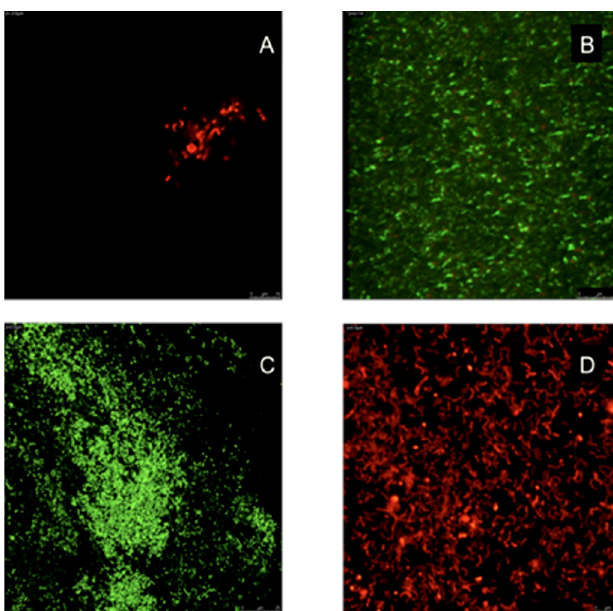
FIGURE 3 - The image shows the bacterial cell culture at 72 hrs. observed in a photodocument system (Bio-Rad of Quantity One). Group 1 (G1), a positive control group treated with 800 µL of thioglycolate + 200 µL of NaOCl 5.25%; group 2 (G2), 1 mL of thioglycolate + laser irradiation (8 min, 33 sec); group 3 (G3), 1 mL δ -ALA (40 µg/mL)-thioglycolate solution; and group 4 (G4), 1 mL of δ -ALA (80 µg/mL)- thioglycolate solution + laser irradiation (8 min, 33 sec) . Yellow shows the UFCs of each of the groups, and there is a lower CFU amount in G4 compared to G2 and G3.